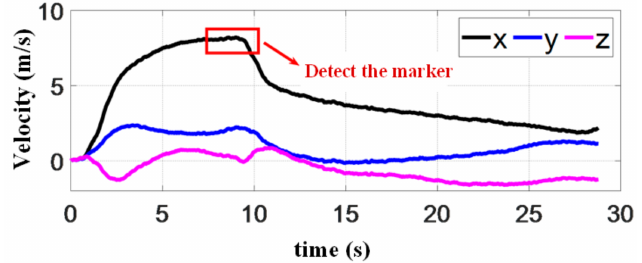
Figure 22. Velocity of the quadrotor in the experiment.